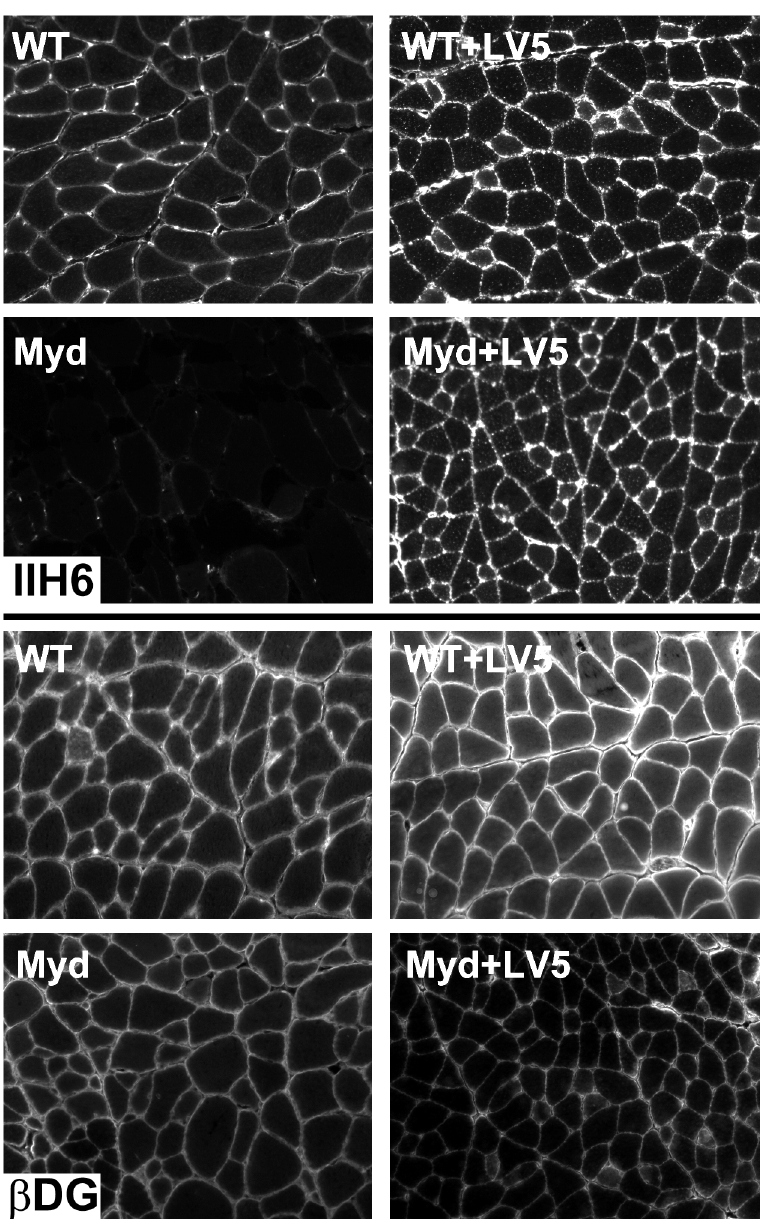
myd mice with or without the LARGE-LV5 transgene (as indicated). Upper panel: IIH6, Lower Panel: β